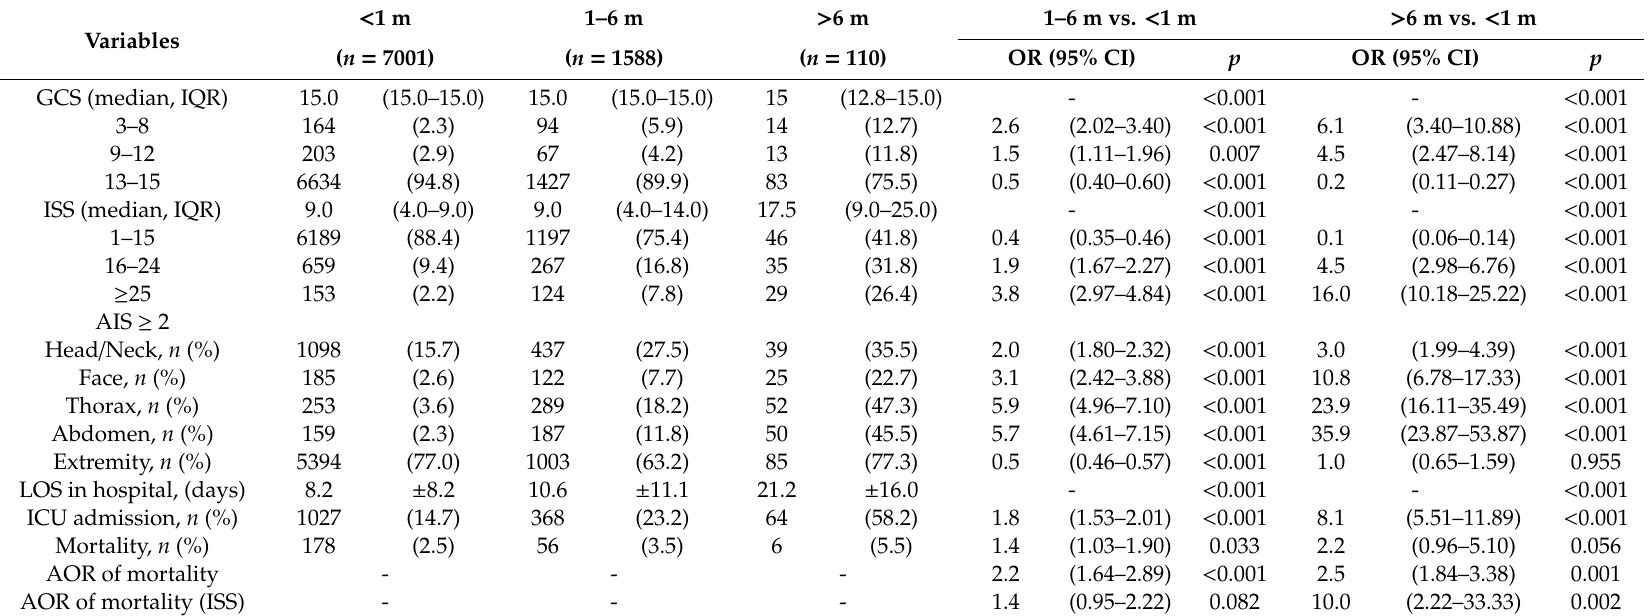
Table 2. Injury characteristics of patients with falls from heights of < 1 m (m), 1–6 m, and > 6